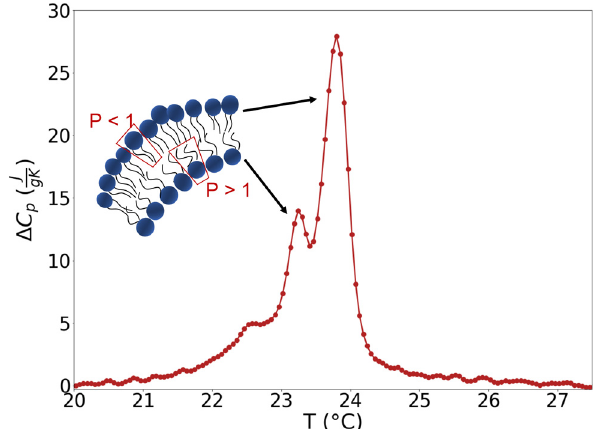
Figure 1: Trend of the speci fi c heat Δ C p at varying temperatures obtained by DSC measurements on DMPC LUVs in ringer bu ff er. Scan rate 3°C/min, cooling